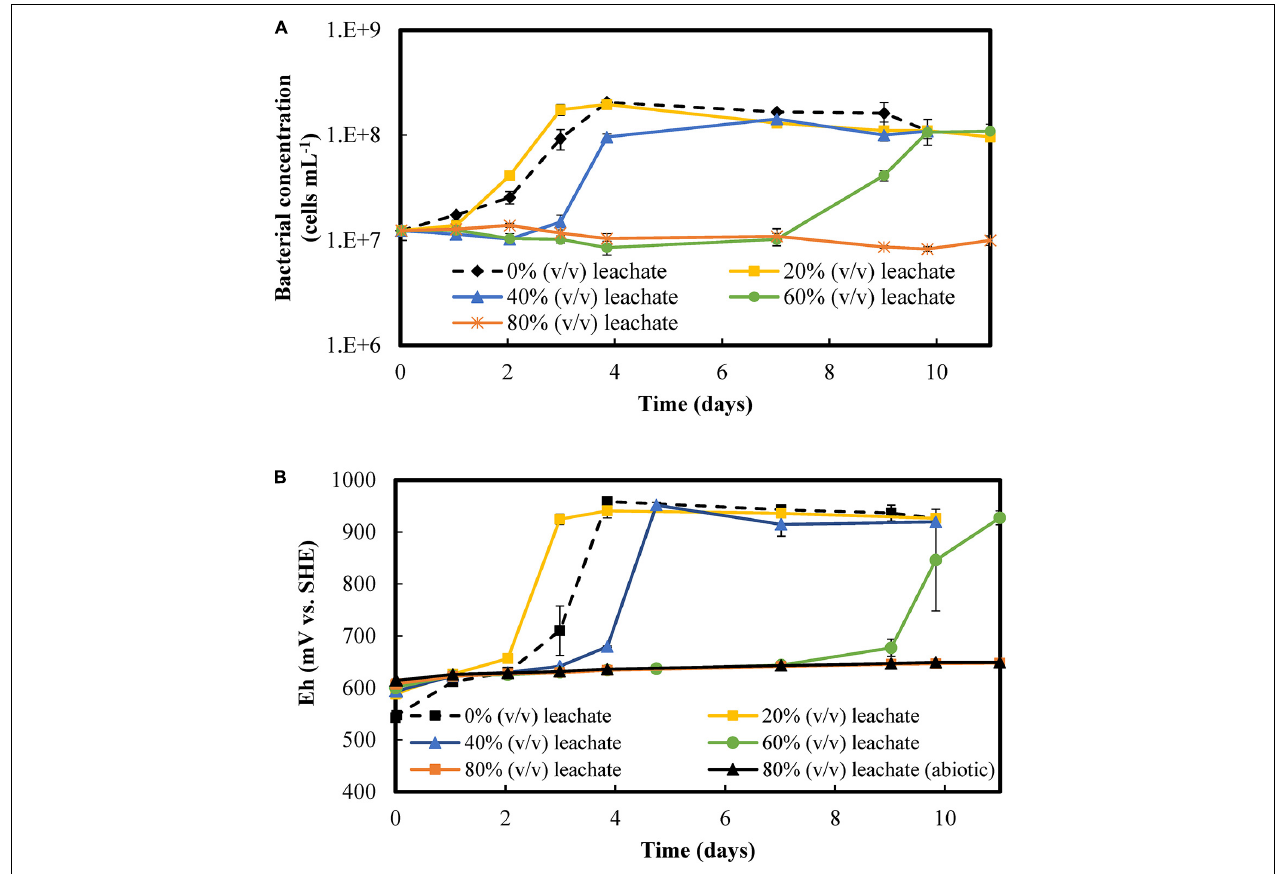
FIGURE 2 | Microbial activity at various concentrations of the chemical leachate produced with 10% (w/v) PCBs: (A) Bacterial concentration and (B) redox potential. The experiments were performed in shake flasks and started with 8 g L - 1 Fe(II) and 10 7 cells mL − 1 . The error bars represent the range of all values obtained under fixed operating conditions. Additional information on experiments with 80% (v/v) leachate the abiotic control is available up to day 25, although no significant changes in either redox behavior or bacterial concentration were observed. TABLE 3 | Final planktonic cell concentration and duration of the pre-oxidation phase in 2.2-l STR PCB bioleaching reactors in batch mode. Non-adapted culture Adapted